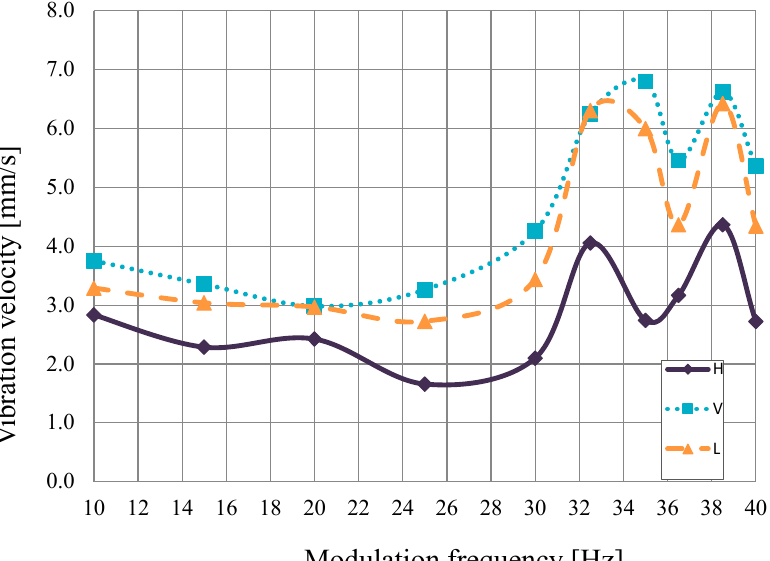
Figure 21. Measured broad-band vibration velocity for Case B in the horizontal (H), vertical (V) and longitudinal (L) directions versus the frequency of the amplitude modulation.